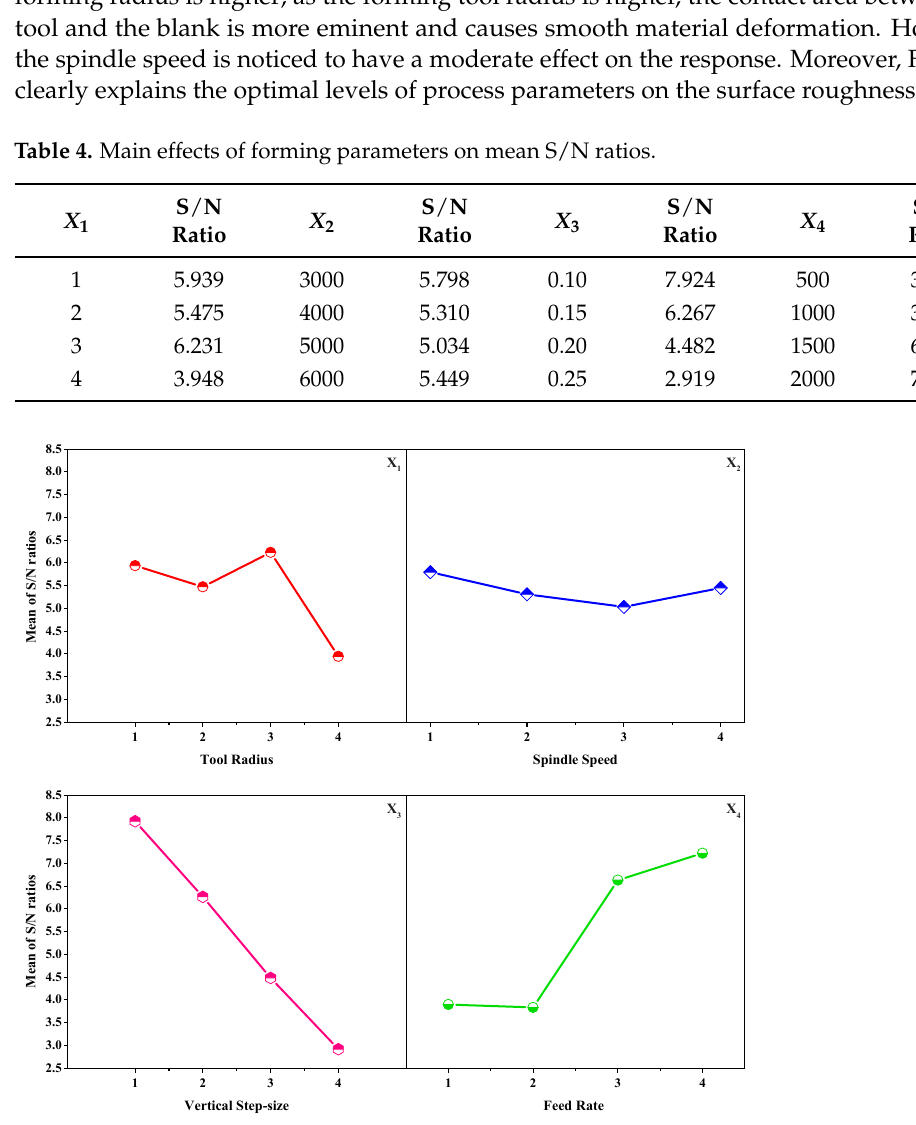
Figure 5. Main effects plot of S/N